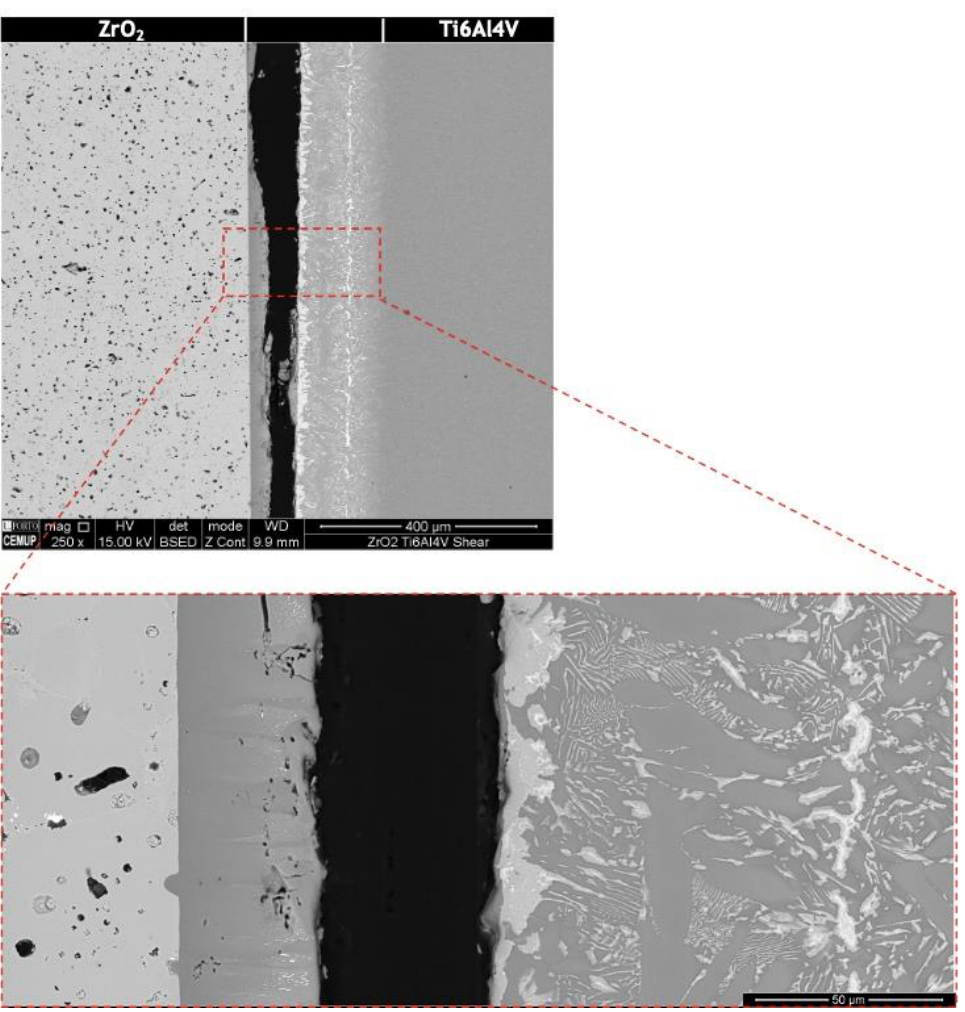
Figure 9. SEM image of the cross-section of the interface of fractured joints, processed at 980 °C after shear testing.